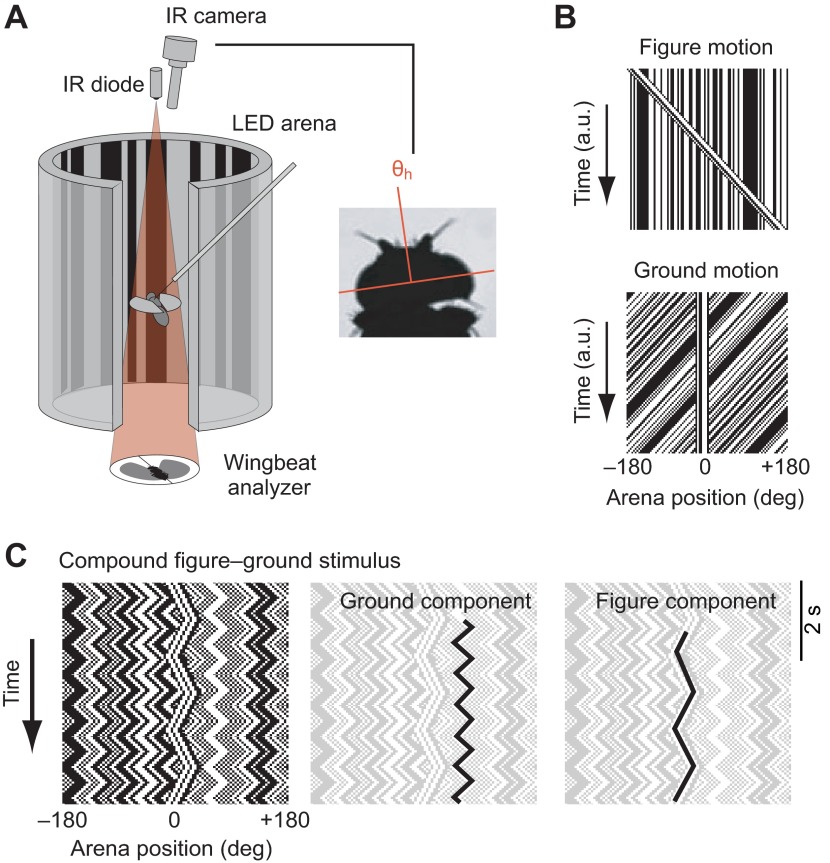
Experimental setup and visual stimuli. (A) Flies are rigidly tethered to pins and suspended between an infrared (IR) LED and two photodiodes, which measure the difference between the fly's left and right wingbeat amplitudes (ΔWBA). They are surrounded by an arena of green LED panels on which various stimuli can be displayed. A camera above the fly records an image of the fly's head (inset), and the angle of the head (θh) is measured with tracking software. (B) Our stimulus consisted of a randomly textured wide-field panorama and a randomly textured bar that could be moved independently. Here, we show space–time plots of a stimulus consisting of simplified motion of only one stimulus component. (C) Triangle-wave stimuli showing figure and wide-field motion moving with two different frequencies of oscillation.